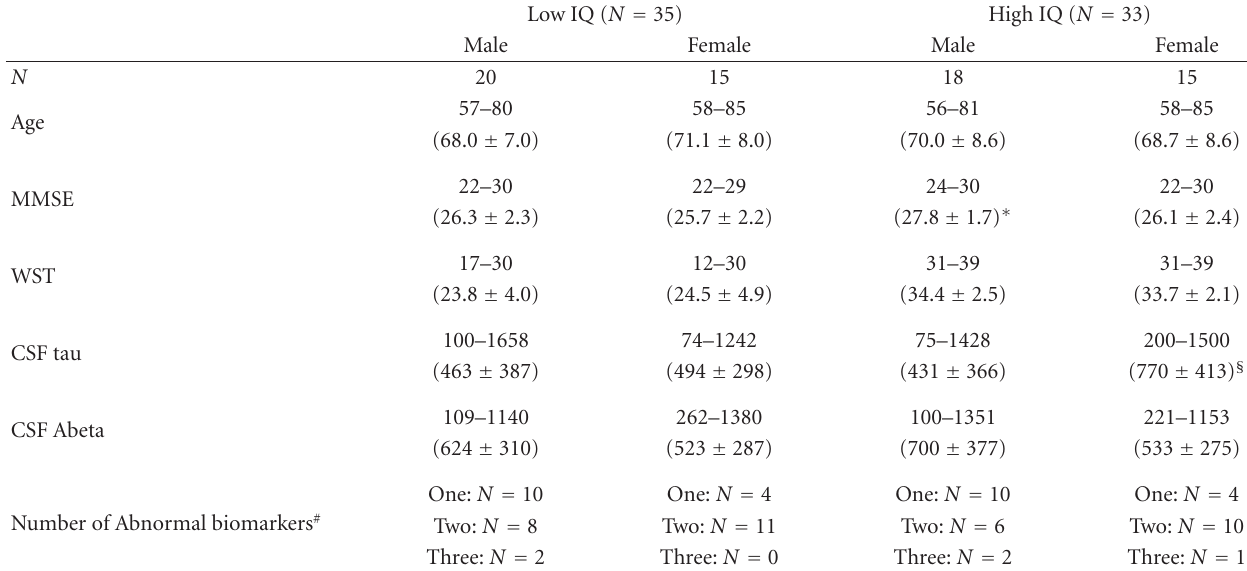
Table 1: Characterization of the study sample: ranges, mean, and standard deviations in brackets . MMSE: Mini-Mental Status Examination; WST: German Vocabulary Test (Wortschatztest) as a measure of Intelligence; CSF: cerebrospinal fluid; Low IQ (IQ < 100); High IQ (IQ >